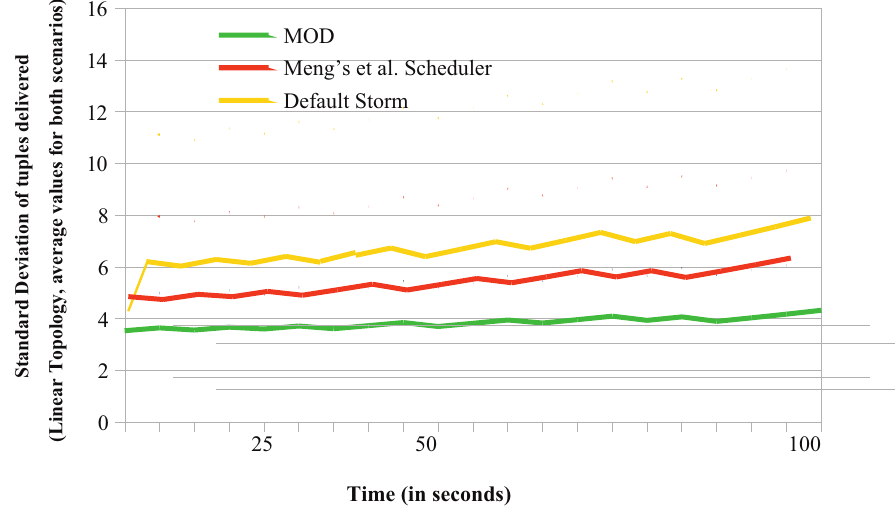
Figure 9. Load balancing comparisons with a random topology for both